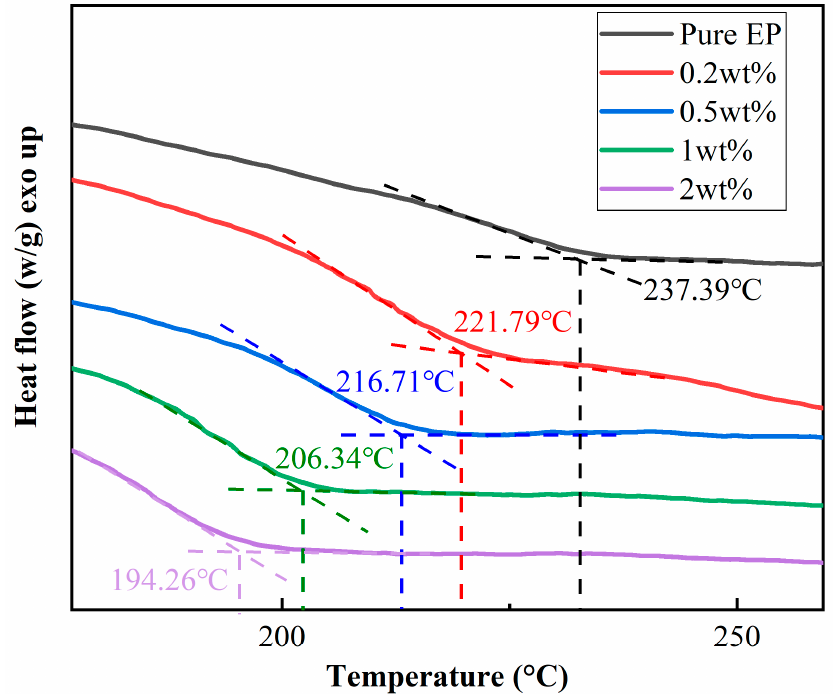
Figure 4. DSC curves of pure EP and BPEI-ZIF-8/IL/EP composites with different contents of BPEI- ZIF-8/IL.